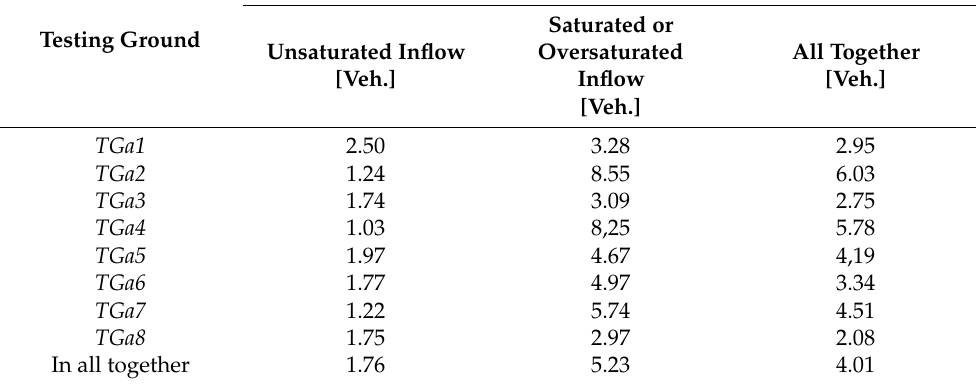
Table 3. Values of errors in estimating the maximum back-of-queue size at the signal-controlled intersection approach